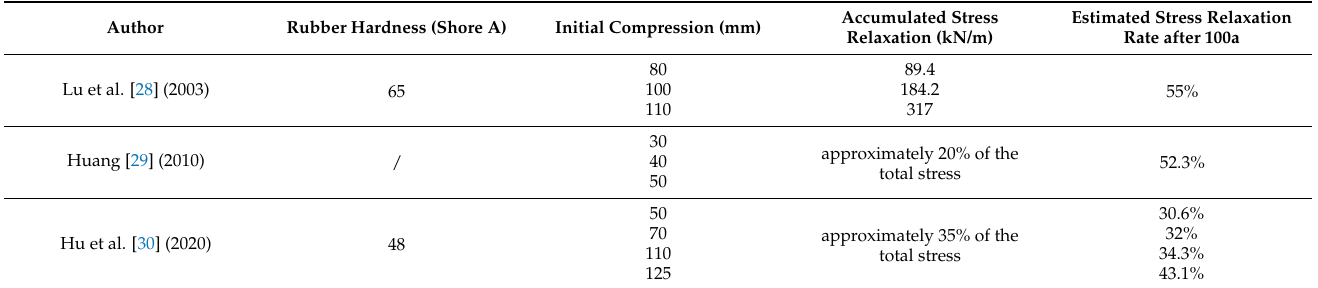
Table 1. Testing results of the stress relaxation rate in previous